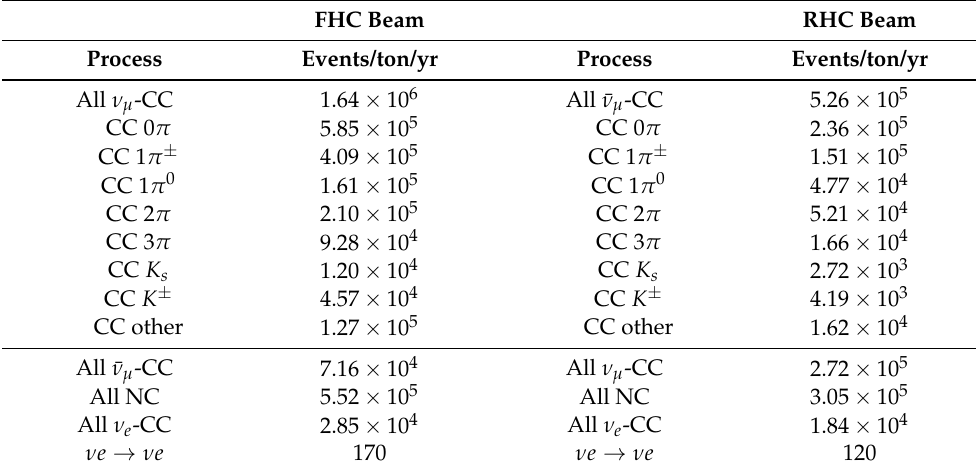
Table 14. Expected event yields in the HPgTPC of ND-GAr. The rates assume one year of running and a 1ton fiducial mass as described in the